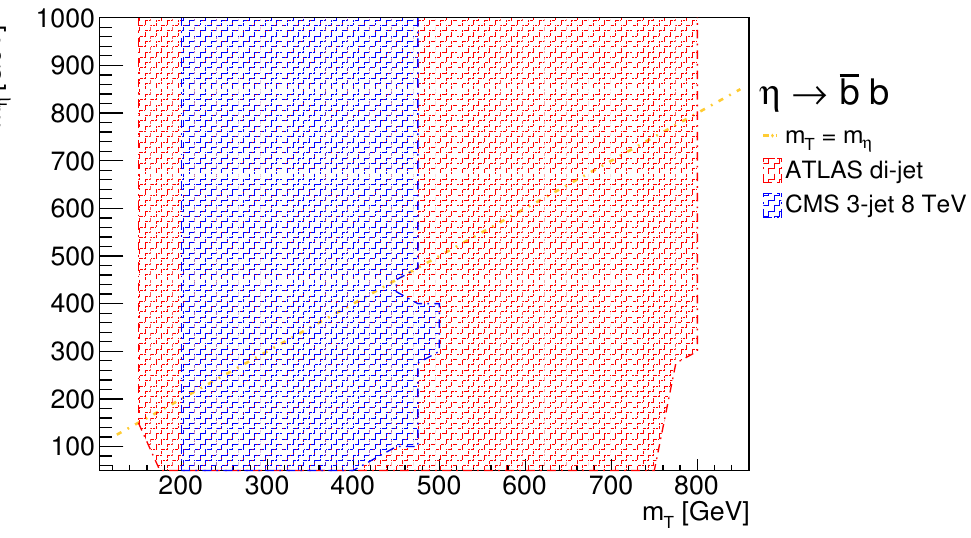
Figure 7. The CMS and ATLAS bounds on the fully hadronic decay mode (to heavy (cid:13)avour jets) of the top partner. The shaded regions are excluded by the current searches conducted at the LHC [50,